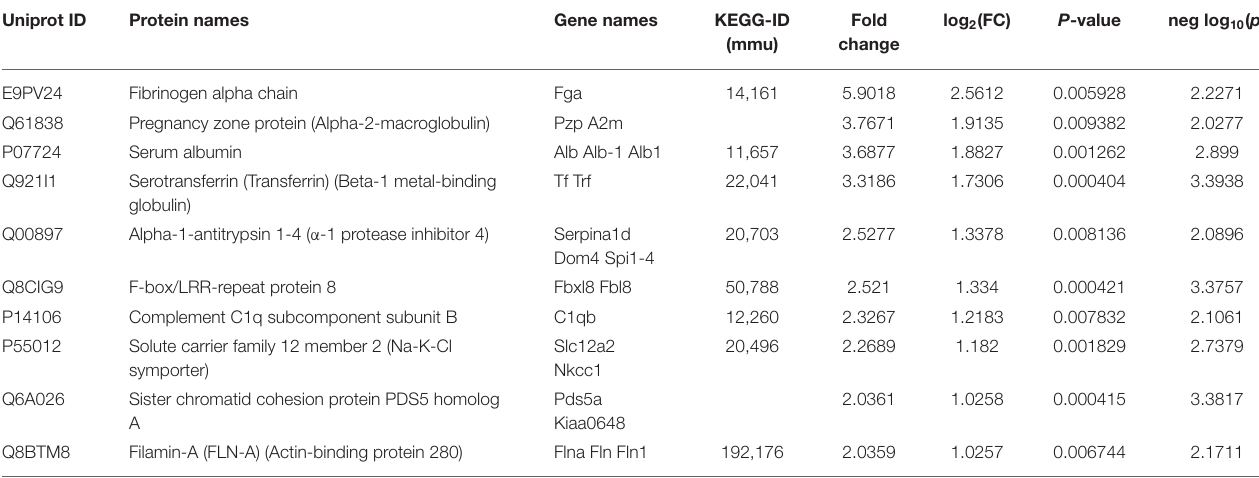
TABLE 4 | The impact of KA-induced SE in intracerebral electrode implanted animals on the expression of proteins in the hippocampus. Uniprot ID Protein names Gene names KEGG-ID